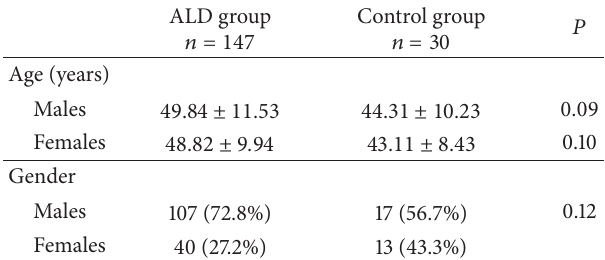
Table 1: Baseline characteristics of the study population ∗